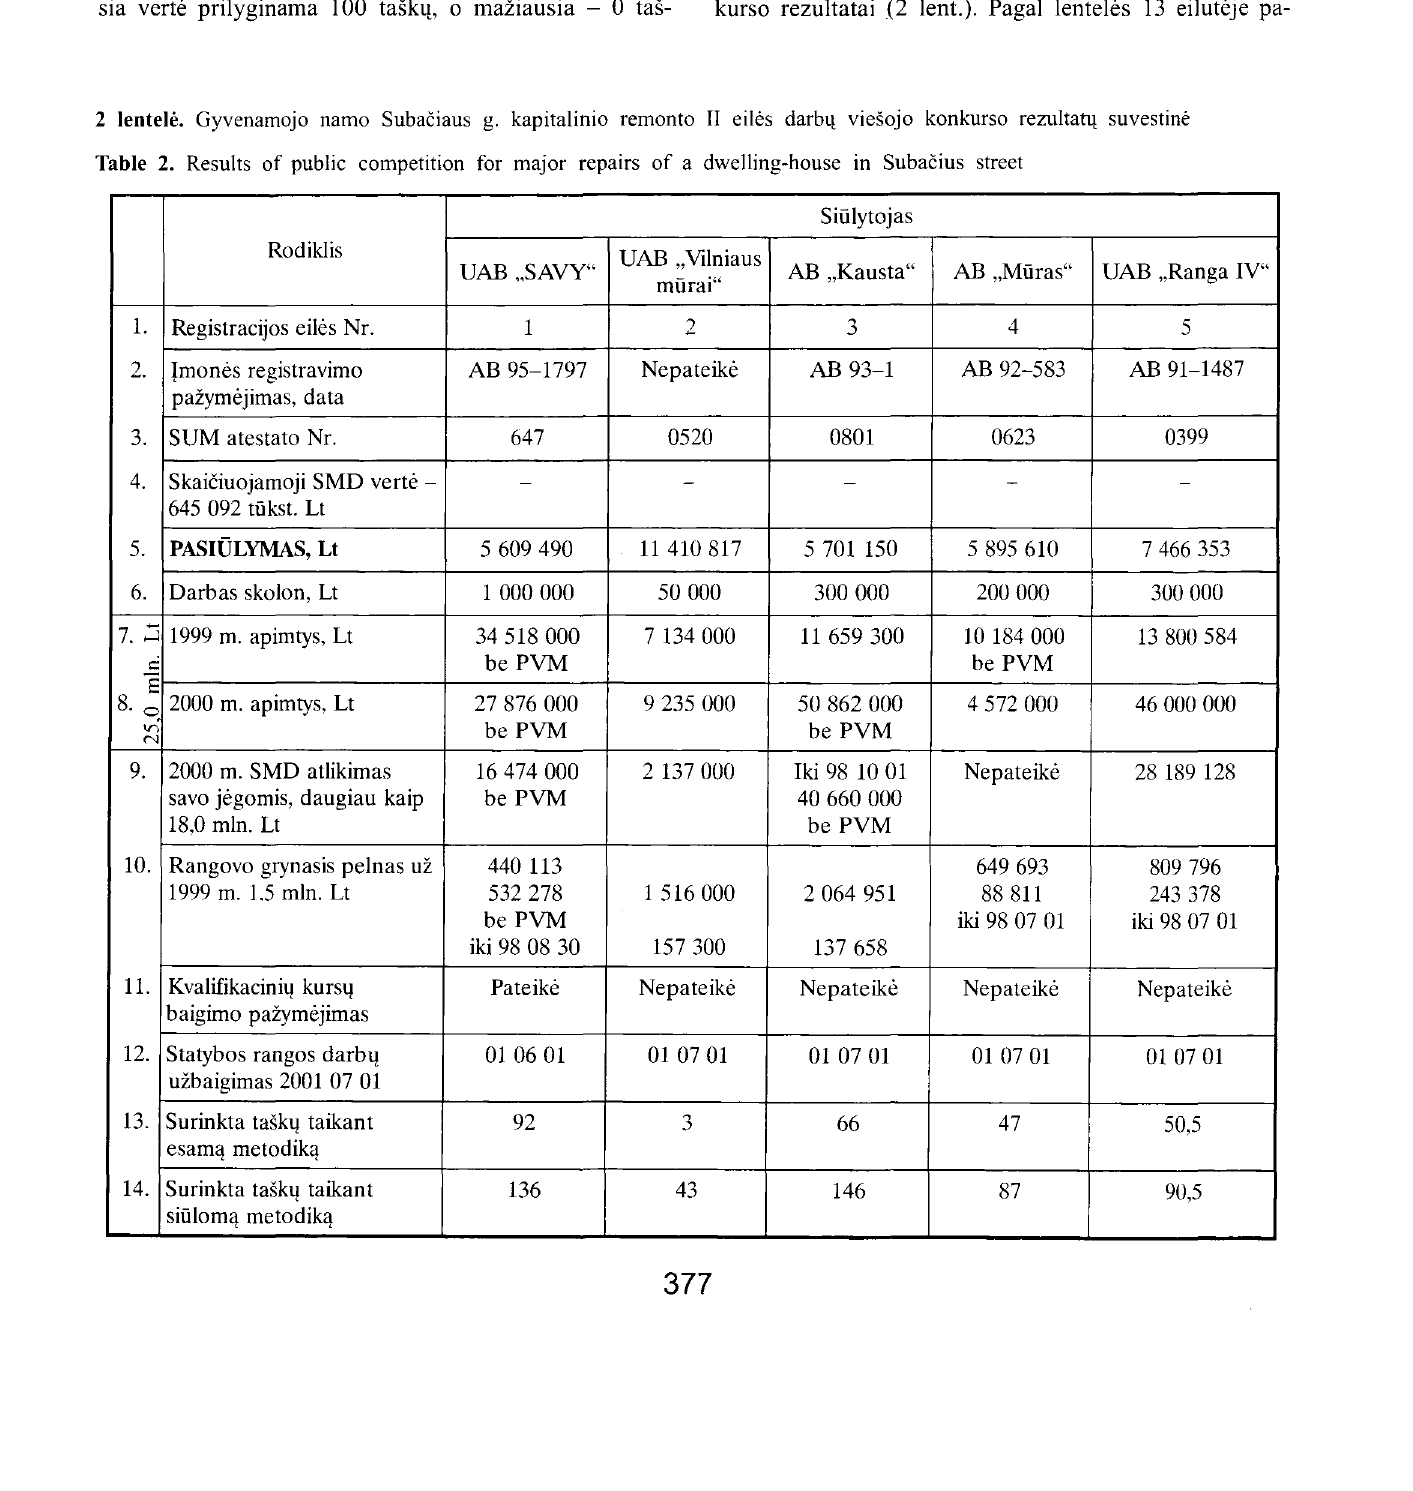
Table 2. Results of public competition for major repairs of a dwelling-house in Subacius street SiUiytojas Rodiklis UAB ,Vilniaus UAB ,SAVY" AB ,Kausta" AB ,Muras" UAB ,Ranga murai"